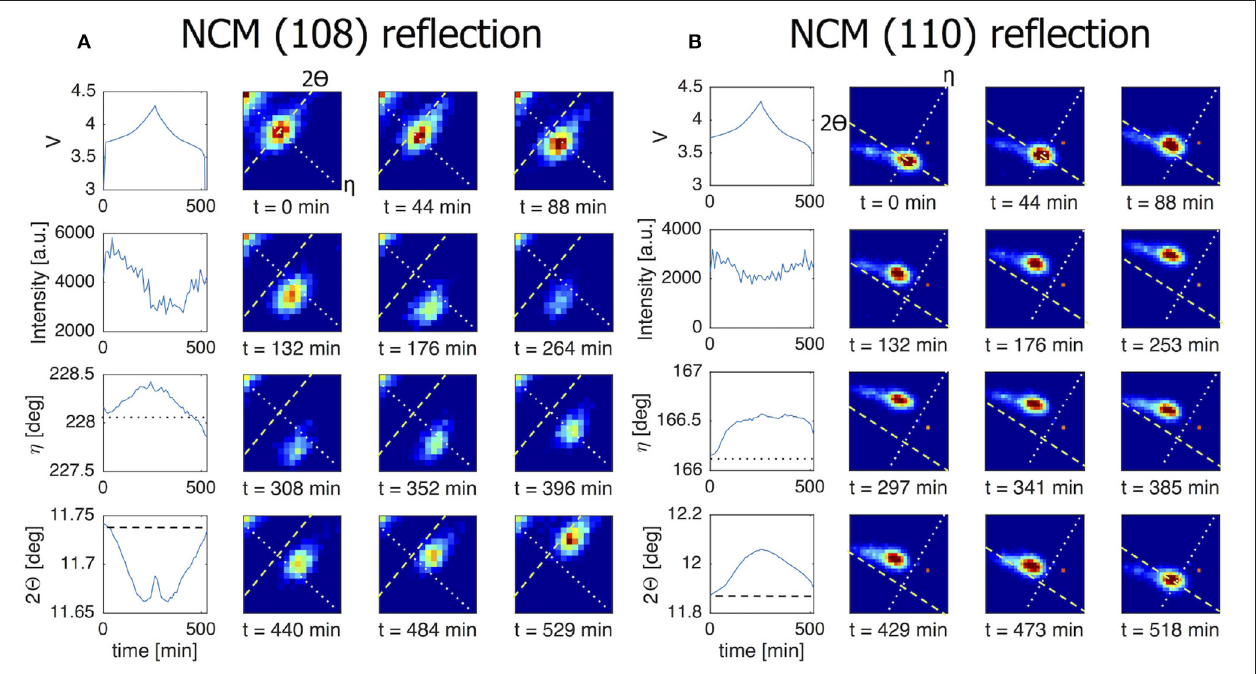
FIGURE 7 | The line charts in the left most column of both figures show from top to bottom the voltage of the battery, the intensity of the grain reflection, the change in the η angle and the change in the 2 2 angle for this particular grain reflection. All for a C/4 charge/discharge cycle. The dotted line in the η graph corresponds to the dotted line shown in the 2D plots. The dashed line in the 2 2 graph corresponds to the dashed line in the 2D plots. (A) NCM (108) reflection that is active throughout the charge/discharge cycle. Here the 2 2 profile reveals the solid solution nature of the material. (B) This (110) reflection also perfectly follows the electrochemistry. The intensity practically does not change throughout the cycle pointing to a constant crystal volume.